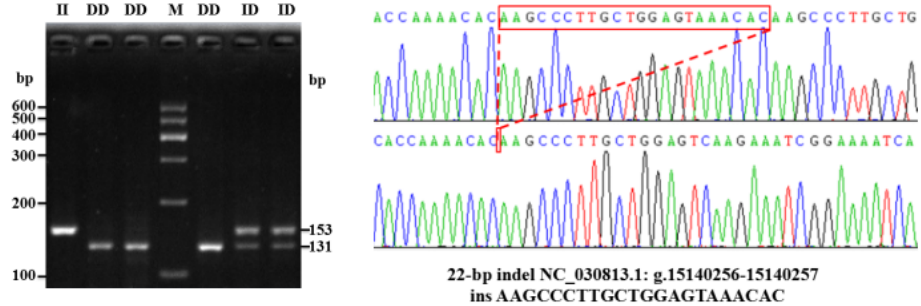
Figure 1. Agarose gel electrophoresis and DNA sequencing of 22bp indel of the goat PITX2 gene. Table 2. Genotypic and allelic frequencies as well as population genetic indices of PITX2 gene in Shaanbei white cashmere (SBWC) goats. Genotypic and allelic frequencies P value Population genetic indexes Genotypes ( n = sample sizes) Alleles (HWE) Ho He Ne PIC ID DD I